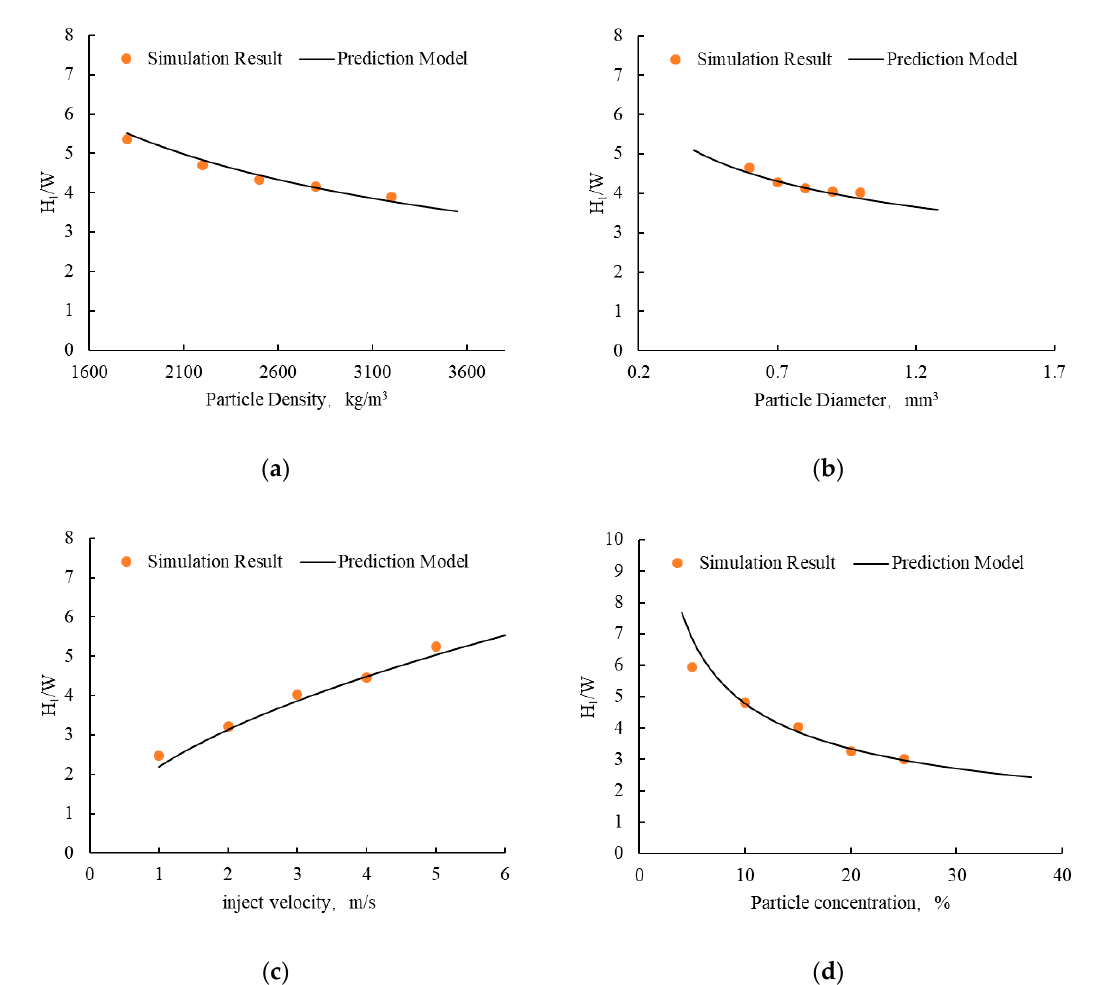
Figure 17. Comparison of the equilibrium dune height between simulation result and new prediction model. ( a ) Comparison of particle density; ( b ) comparison of particle diameters; ( c ) comparison of injection velocity; and ( d ) comparison of particle concentration.